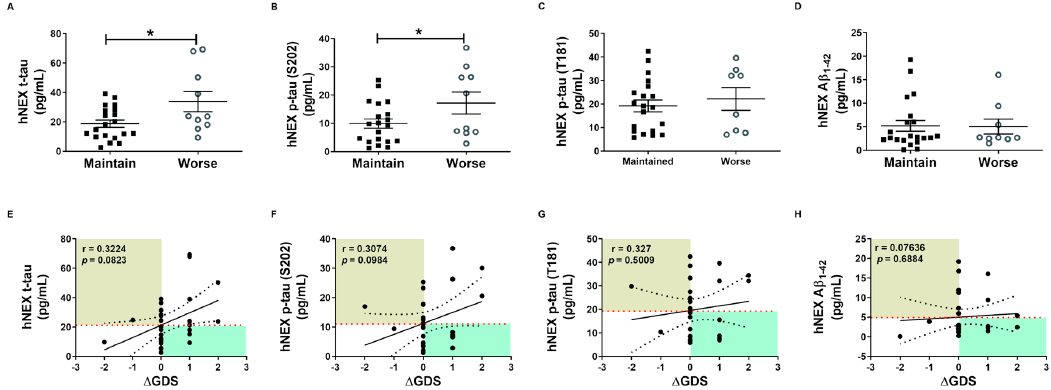
Figure 4. Total tau and phosphorylated tau protein levels in neuronal cell-derived exosomes predict cognitive deterioration. Comparisons of baseline hNEX A ) t-tau, B ) p-tau (S202), C ) p-tau (T181),